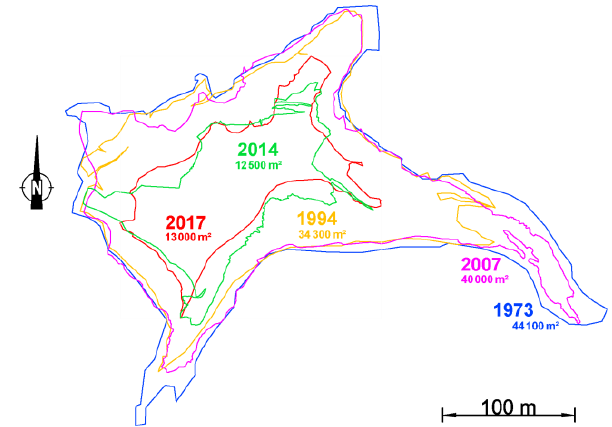
Figure 3. Minimum surface area of the Ice Chapel measured at the end of the ablation season (October) of the respective